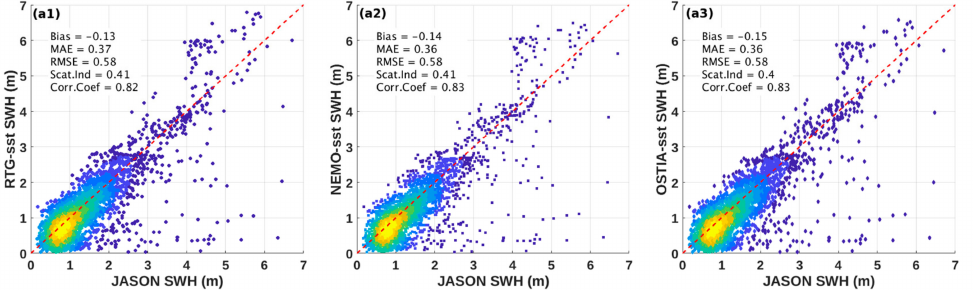
Figure 14. Density scatter plots between modeled and JASON (satellite) significant wave heights for ( a1 ) RTG-sst, ( a2 ) NEMO-sst and ( a3 ) OSTIA-sst simulations, gathering all experimental